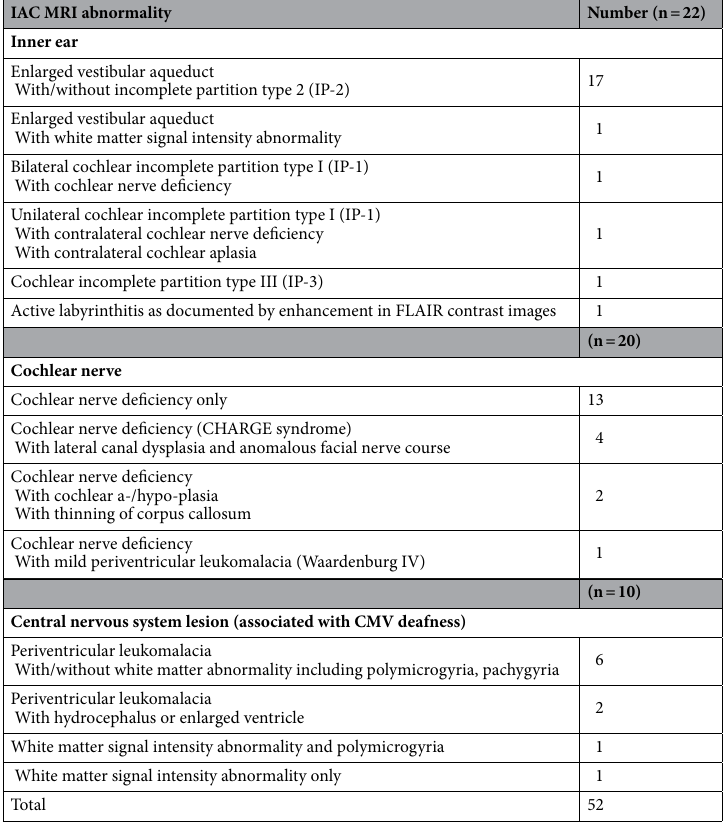
Table 3. Detailed IAC-MRI abnormal findings in our pediatric SP-SNHL cohort.